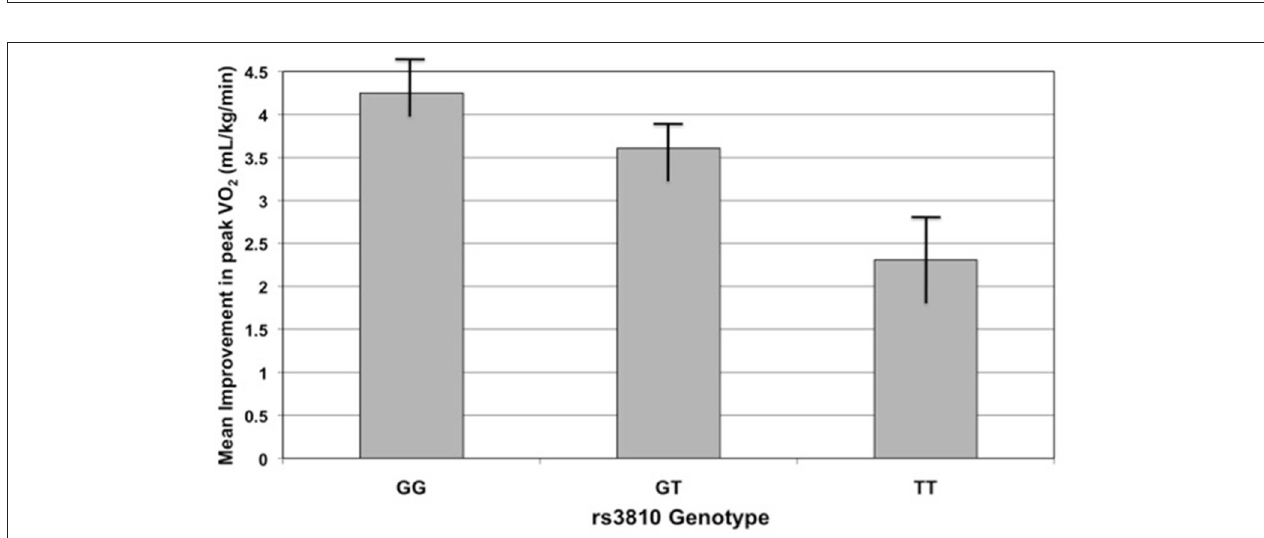
FIGURE 4 | Improvement in peak oxygen consumption (peak VO 2 ) with exercise training by rs3810 genotype. Improvement in peak VO 2 (mL/kg/min), measured as the difference in peak VO 2 before and after an exercise intervention, compared to rs3810 genotype. STRRIDE I and STRRIDE II datasets were combined for the analysis (GG genotype n = 168, GT genotype n = 207, TT genotype n = 90). The rs3810 genotype significantly predicted change in peak VO 2 ( p = 0.0185), despite the fact that some groups differed in the intensity of the training